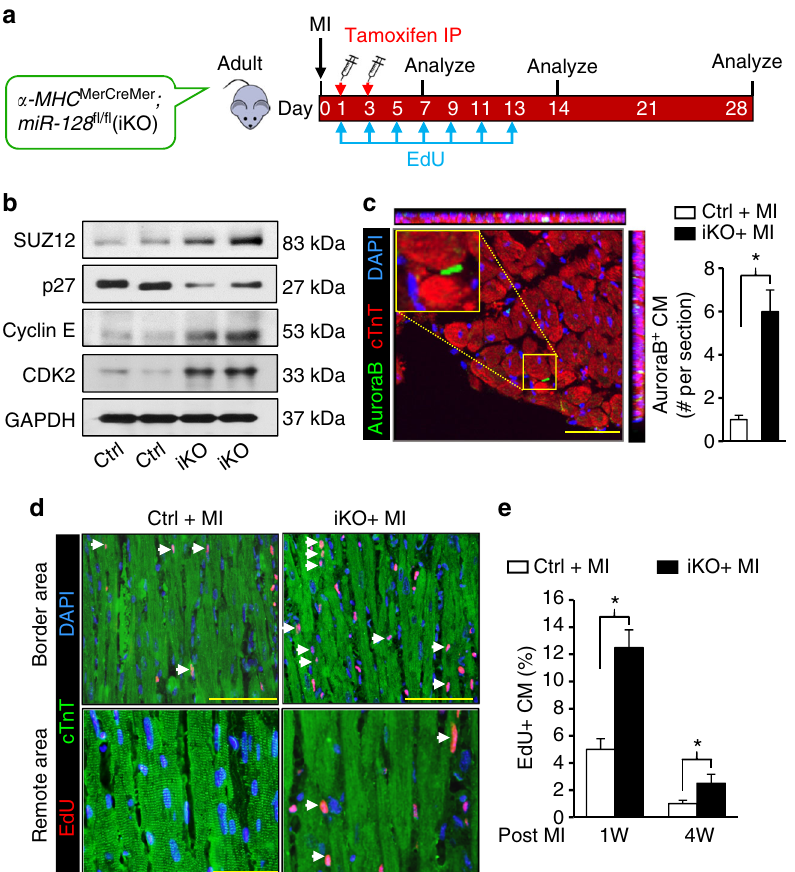
Fig. 8 MiR-128 deletion promotes adult cardiomyocyte proliferation after MI. a Schematic of the experimental design for assessing adult (12-weeks-old) cardiac regeneration following MI in TAM-inducible miR-128 knockout (iKO) mice. Control (Ctrl) mice were miR-128 fl / fl mice, and iKO mice were α - MHC MerCreMer ; miR-128 fl / fl mice. b Western blot analysis of cell cycle-related gene expression in infarcted hearts at day 7 after TAM administration ( n = 3). c Immunostaining of Aurora B in infarcted hearts at day 14 after TAM administration ( n = 5 mice, ~400 CMs/heart). Scale bars, 250 pixel. d Evaluation of CM proliferation by EdU incorporation assay. Scale bars, 50 µ m. e Quanti fi cation of EdU + CMs in the Ctrl and iKO hearts at 1 week (1 W) and 4 weeks (4 W) post MI ( n = 5 mice, ~250 CMs/heart). Statistical signi fi cance was calculated using Student ’ s t -test in c , e . Data are represented as means ± SEM. * P <